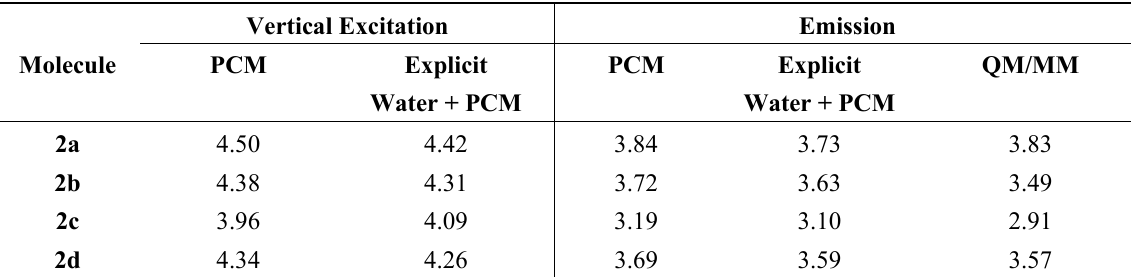
Table 2. Franck-Condon vertical excitation and emission energies calculated using LRC- ω PBE/6-31G(d) using the PCM model with additional explicit water molecules and also calculated using the QM/MM approach. All energies in